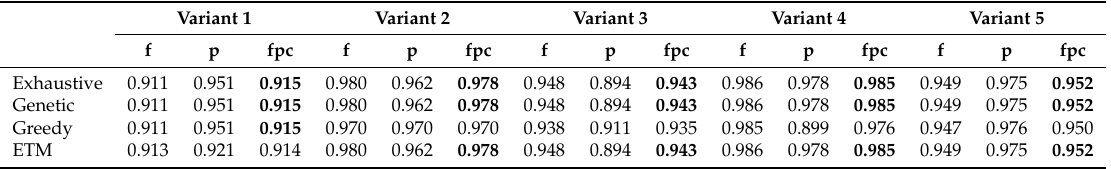
Table 5. Results for CPT 4-B and the event logs corresponding to the five process variants. Variant 1